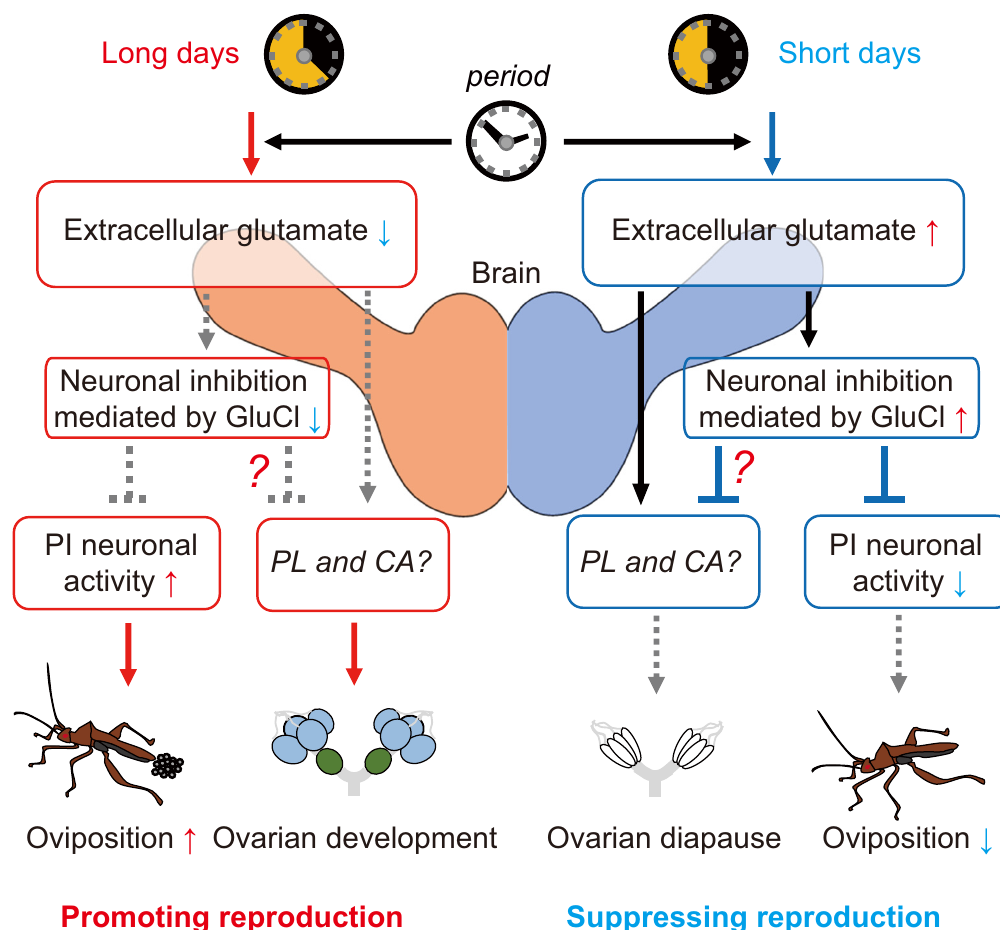
Fig 8. Schematic illustration shows predicted hierarchical glutamatergic pathway for reproductive control. Brain glutamate levels photoperiodically change depending on the clock gene period . A glutamatergic signal photoperiodically inhibits the PI neuronal activity via GluCl, which contributes to control of oviposition. The glutamatergic signal may parallelly regulate neuroendocrine centers (such as PL and CA) for photoperiodic regulations of ovarian development. CA, corpus allatum; GluCl, glutamate-gated chloride channel; PI, pars intercerebralis; PL, pars lateralis.